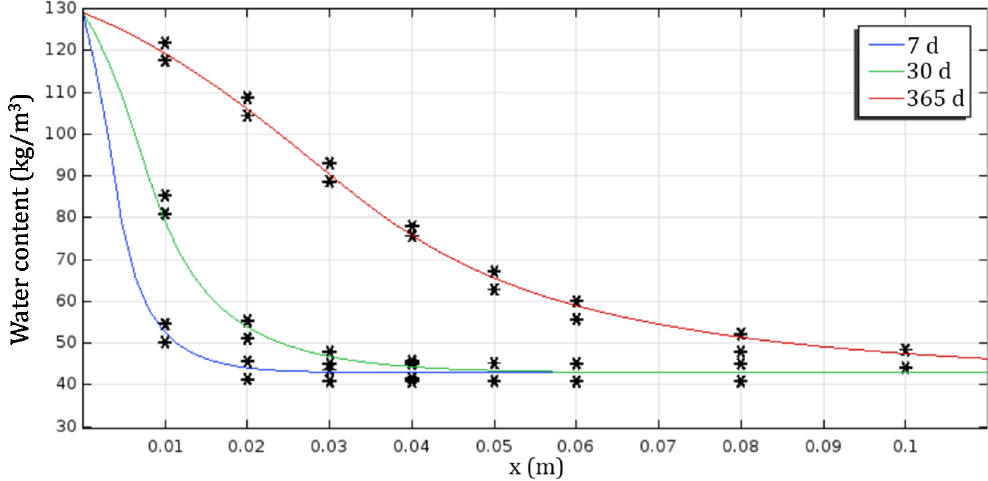
Figure 3. Comparison of the water content profiles obtained numerically (continuous lines) with those of the EN 15026 standard (asterisks).